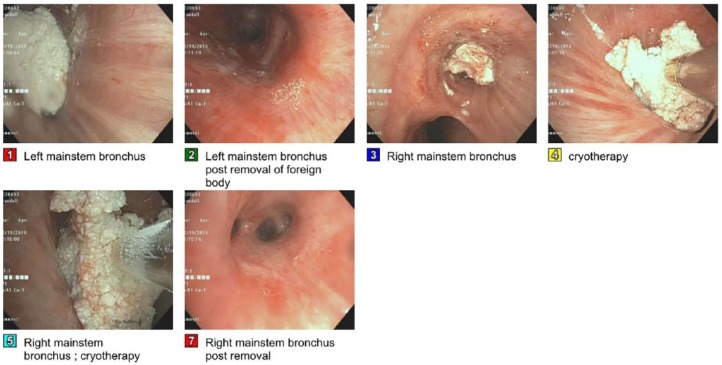
Bronchoscopy images.